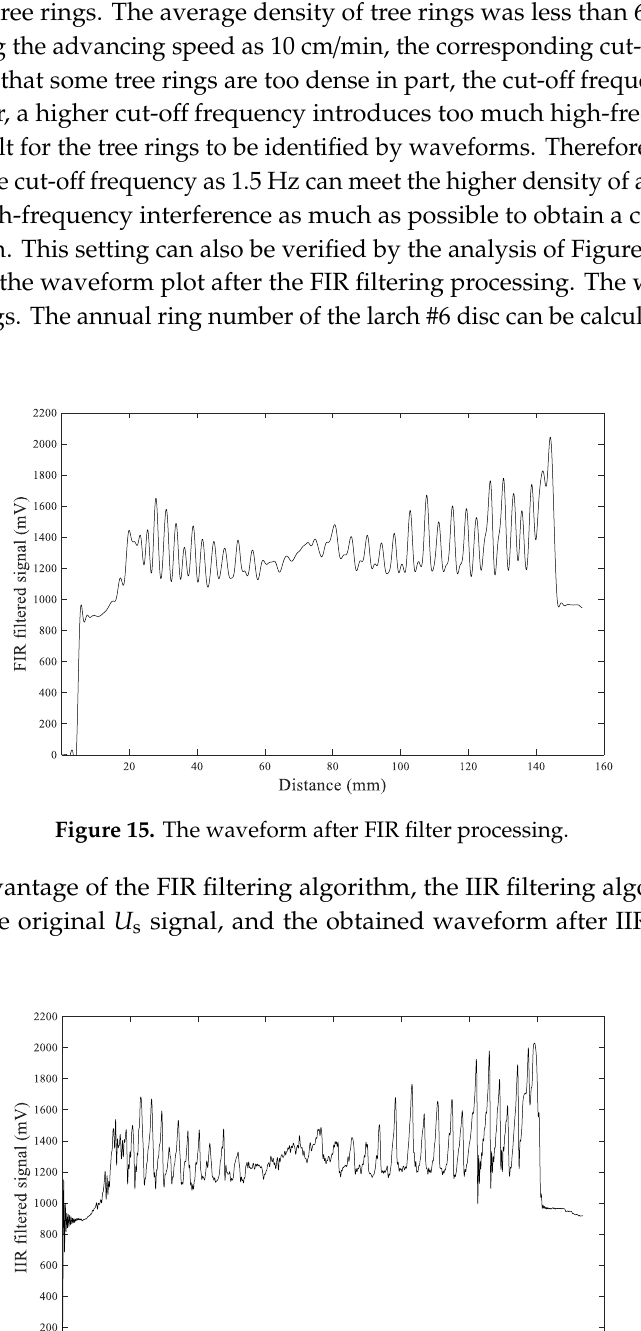
Figure 14. The signal frequency spectrum (19–21.5 Hz).